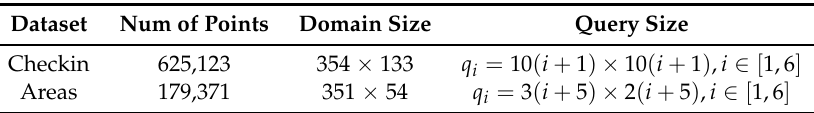
Table 2. Parameter information about datasets.